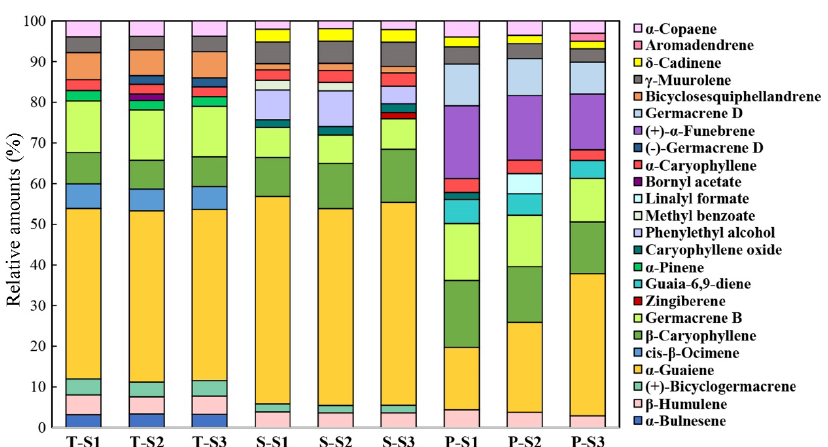
Figure 2. Major components (>1%) of floral volatiles emitted from M. crassipes . (T: tepals; S: stamens; P: pistil; S1: bud stage; S2: initial flowering stage; S3: full flowering stage).